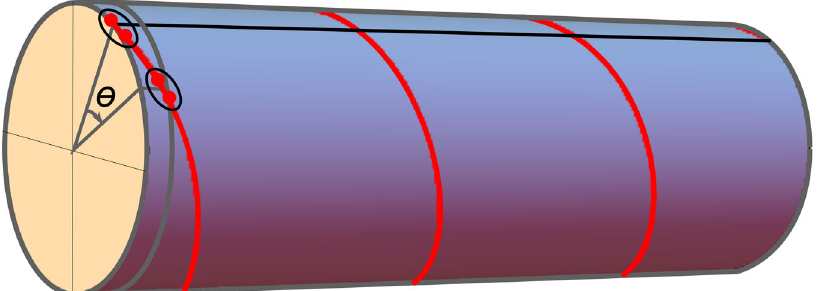
Fig. 3 Geometry. Spiral of arm 1 (red color) with angle θ between sites 1 and 2. The phase of the twisted light is zero along the z -direction (black